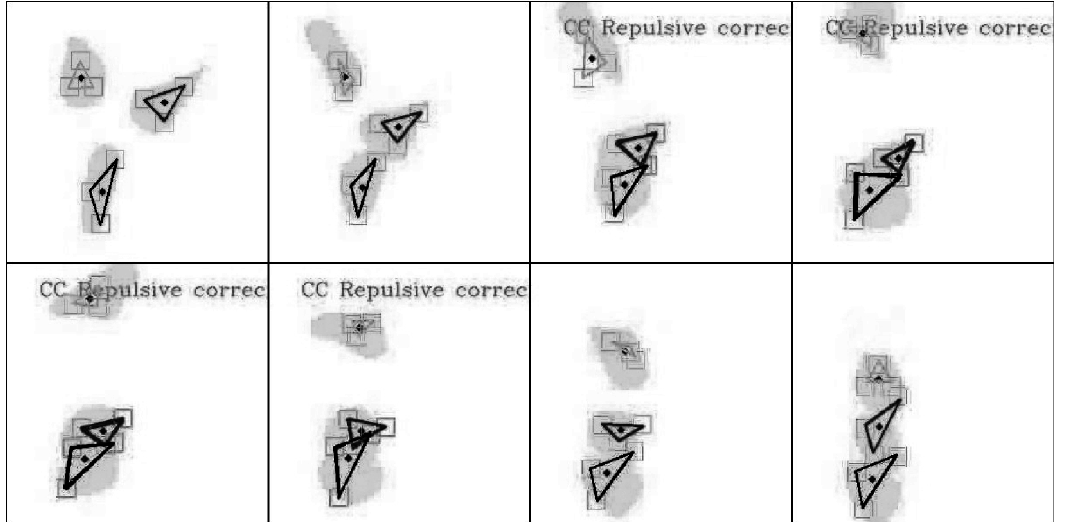
Figure 8: Image sequences obtained from tracking Treg cells after data smoothing and threshold- ing. The sequence illustrates the ability of the constrained SMC clusters to maintain the unique identification of cells despite a merging